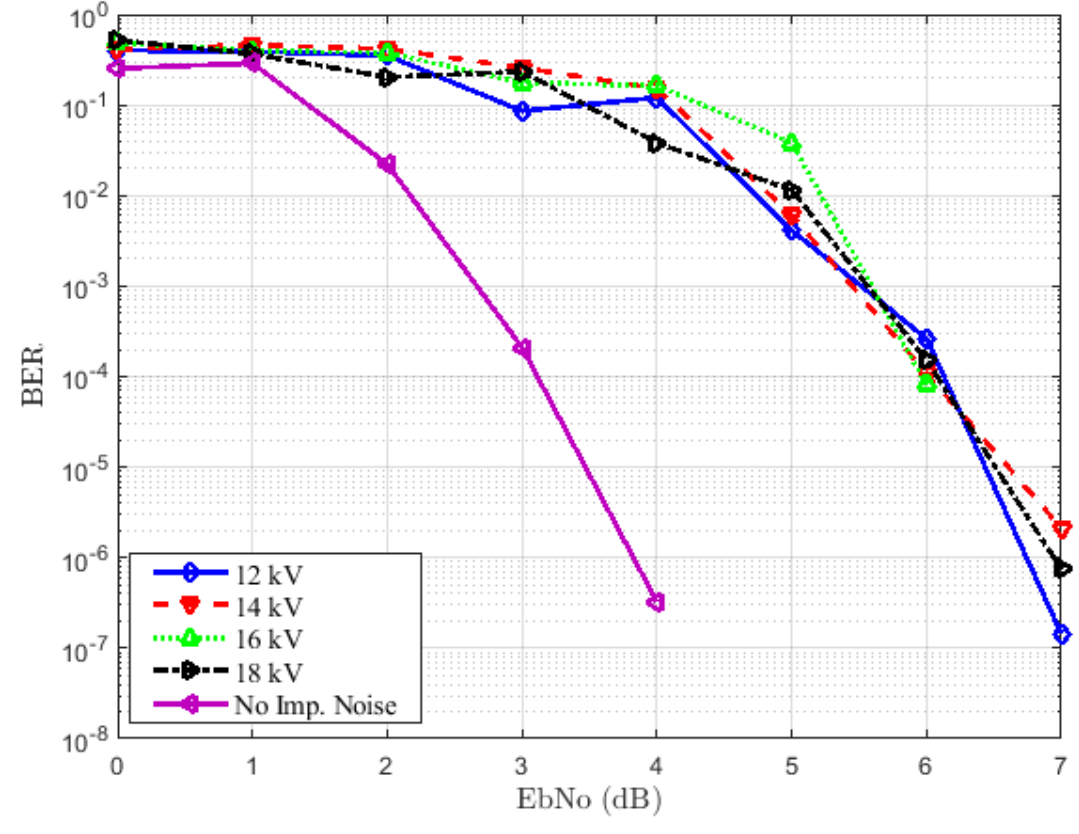
Figure 8. BER performance for different voltages in the LOS